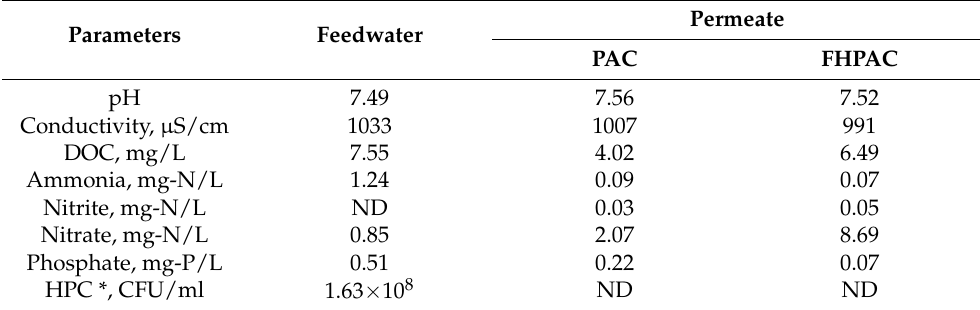
Table 2. Water quality analysis of feed and permeate from the PAC + UF and FHPAC + UF systems.